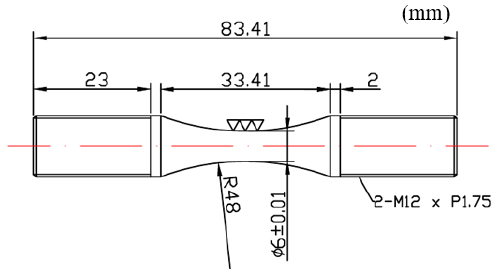
Figure 15. The fatigue test specimen at high temperature. Table 6. The fatigue test result of SKD61 at 400 °C.